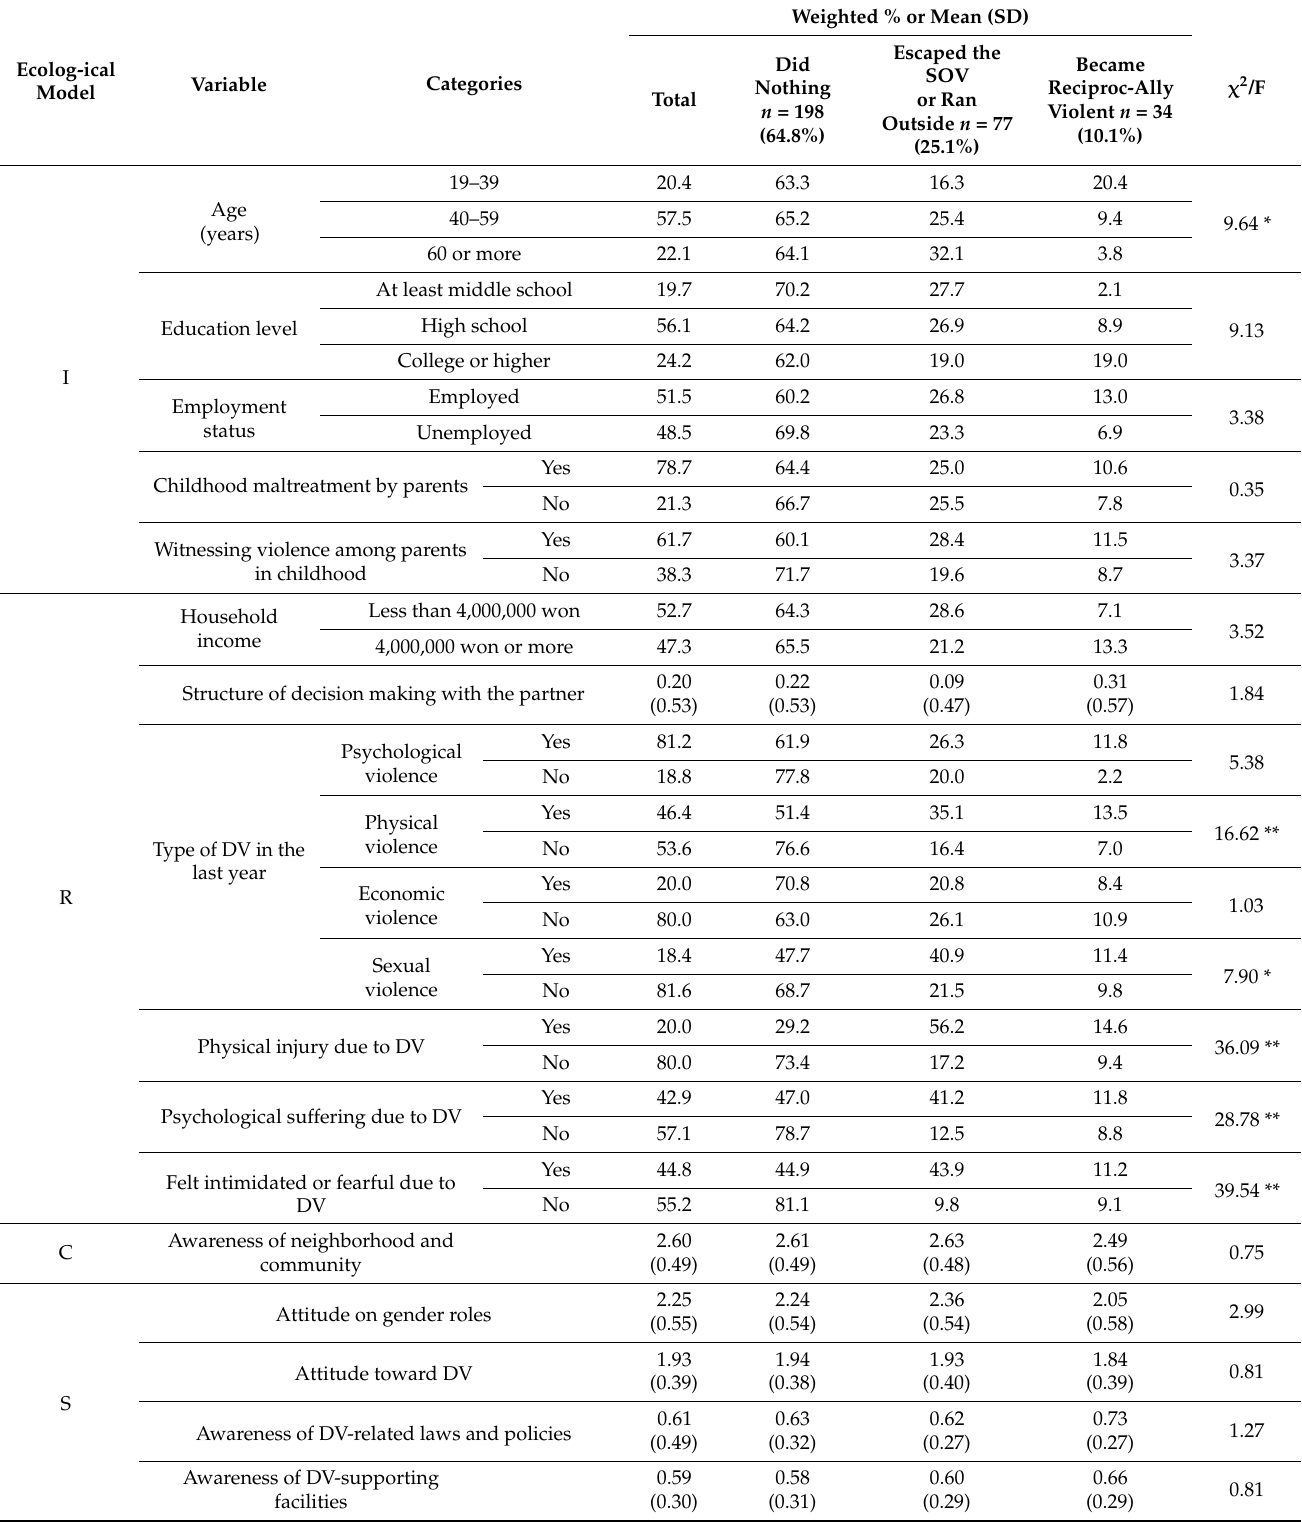
Table 1. Group differences in multi-level factors by three coping behaviors ( n =